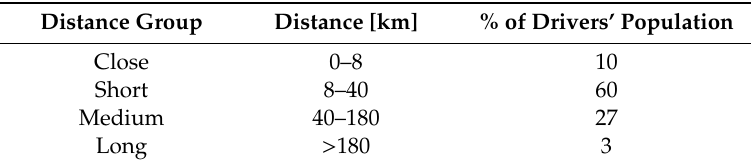
Table 2. Daily distance traveled. Percentage of drivers’ population categorized by distance